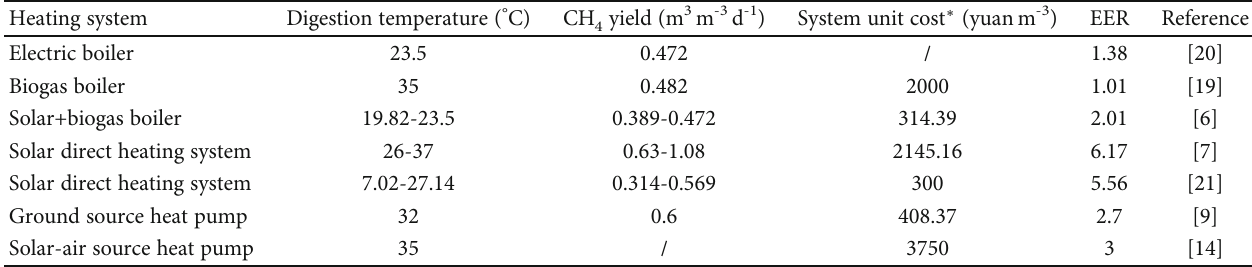
Table 1: Comparison of di ff erent biogas heating